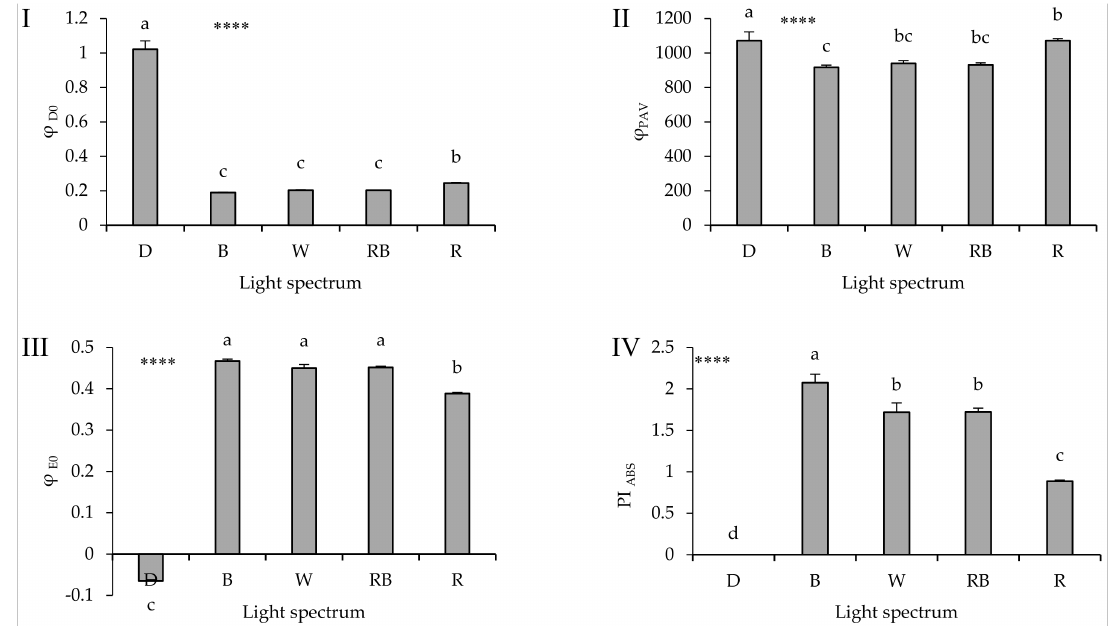
Figure 8. Quantum yield of energy dissipation ( ϕ D0 ; I ), quantum yield for primary photochemistry ( ϕ PAV ; II ), quantum yield of electron transport ( ϕ E0 ; III ), performance index in light absorption basis (PI ABS ; IV ); equations and explanations in Table 2) from the fluorescence transient exhibited by leaves sampled from grafted watermelon seedlings exposed for 12 days to either darkness (D) or different light quality regimes [blue (B), white (W), red and blue (RB), as well as red (R); see spectrum in Supplementary Figure S3]. Photosynthetic photon flux density was 20 ± 1 µ mol m − 2 s − 1 during the first 2 days, and 50 ± 1 µ mol m − 2 s − 1 during the following days. Nine plants per treatment were assessed. Different letters indicate that values are significantly different at p < 0.01 according to Duncan’s multiple range tests. Bars represent SEM. Significance at the 0.0001 probability level is indicated by ****.